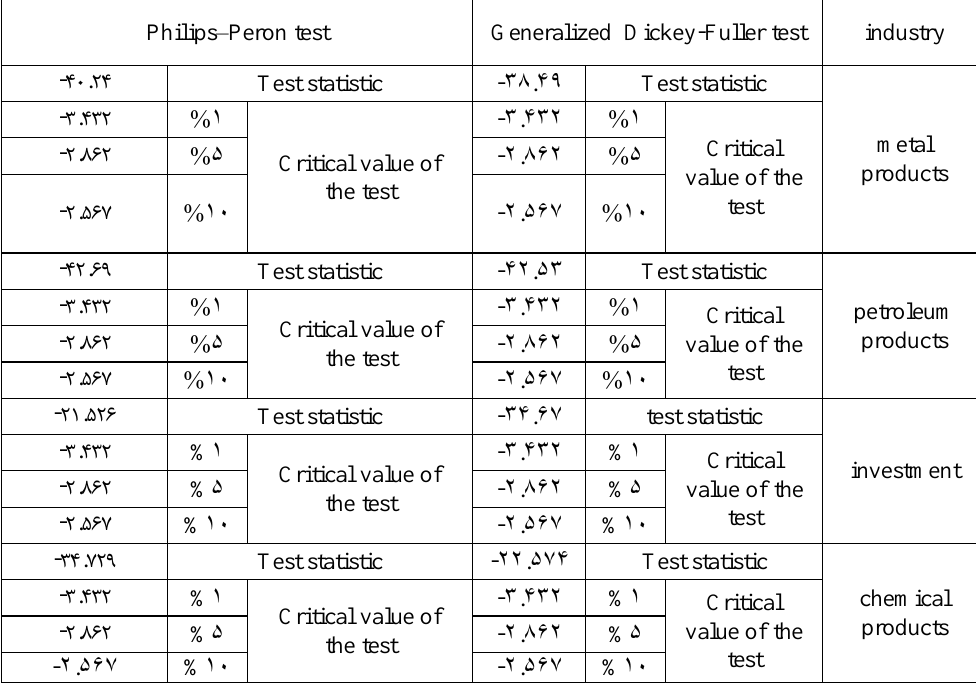
Table 2. Durability test based on ADF and the PP